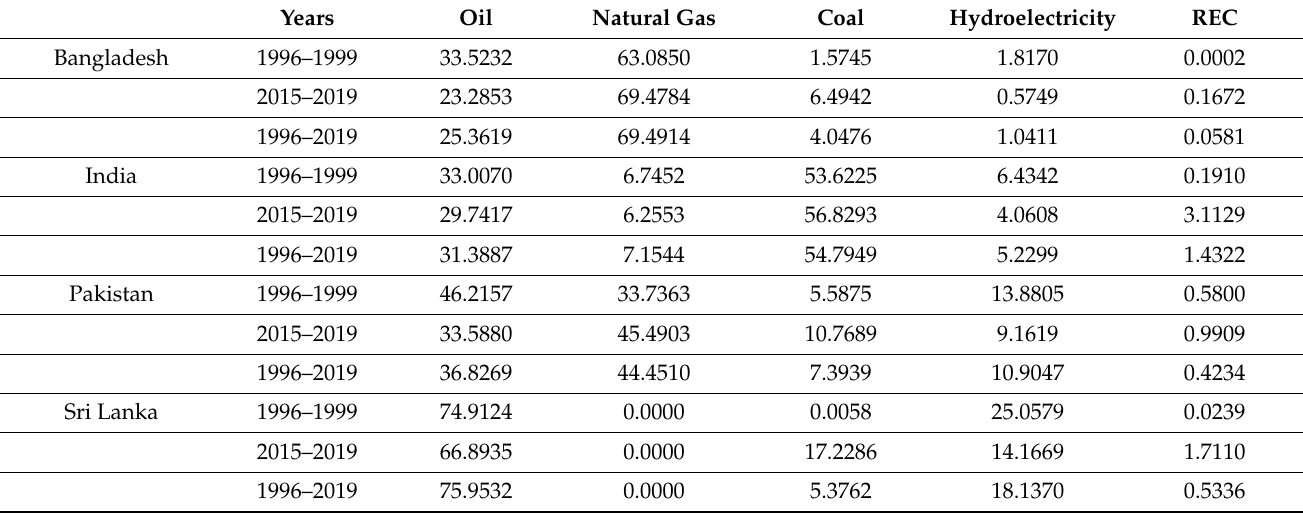
Table 1. Five-year average of the percentage of energy sources in total energy consumption. Years Oil Natural Gas Coal Hydroelectricity